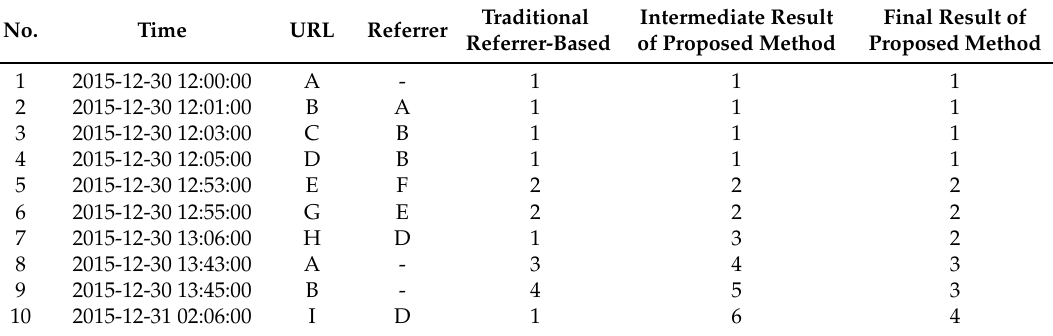
Table 3. Comparison of result with traditional referrer-based method, intermediate and final result of time-referrer-based heuristics.